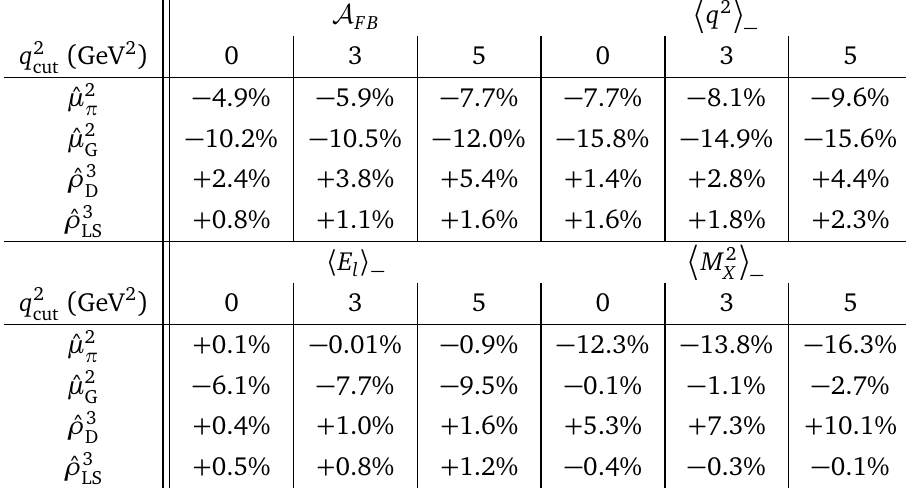
Table 2: perturbative parameters. The contributions are given as percentage of the